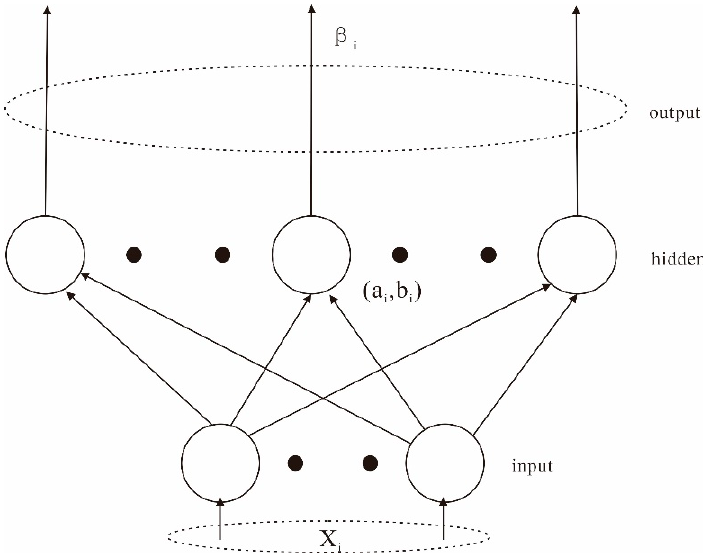
Figure 4. Schematic diagram of ELM.